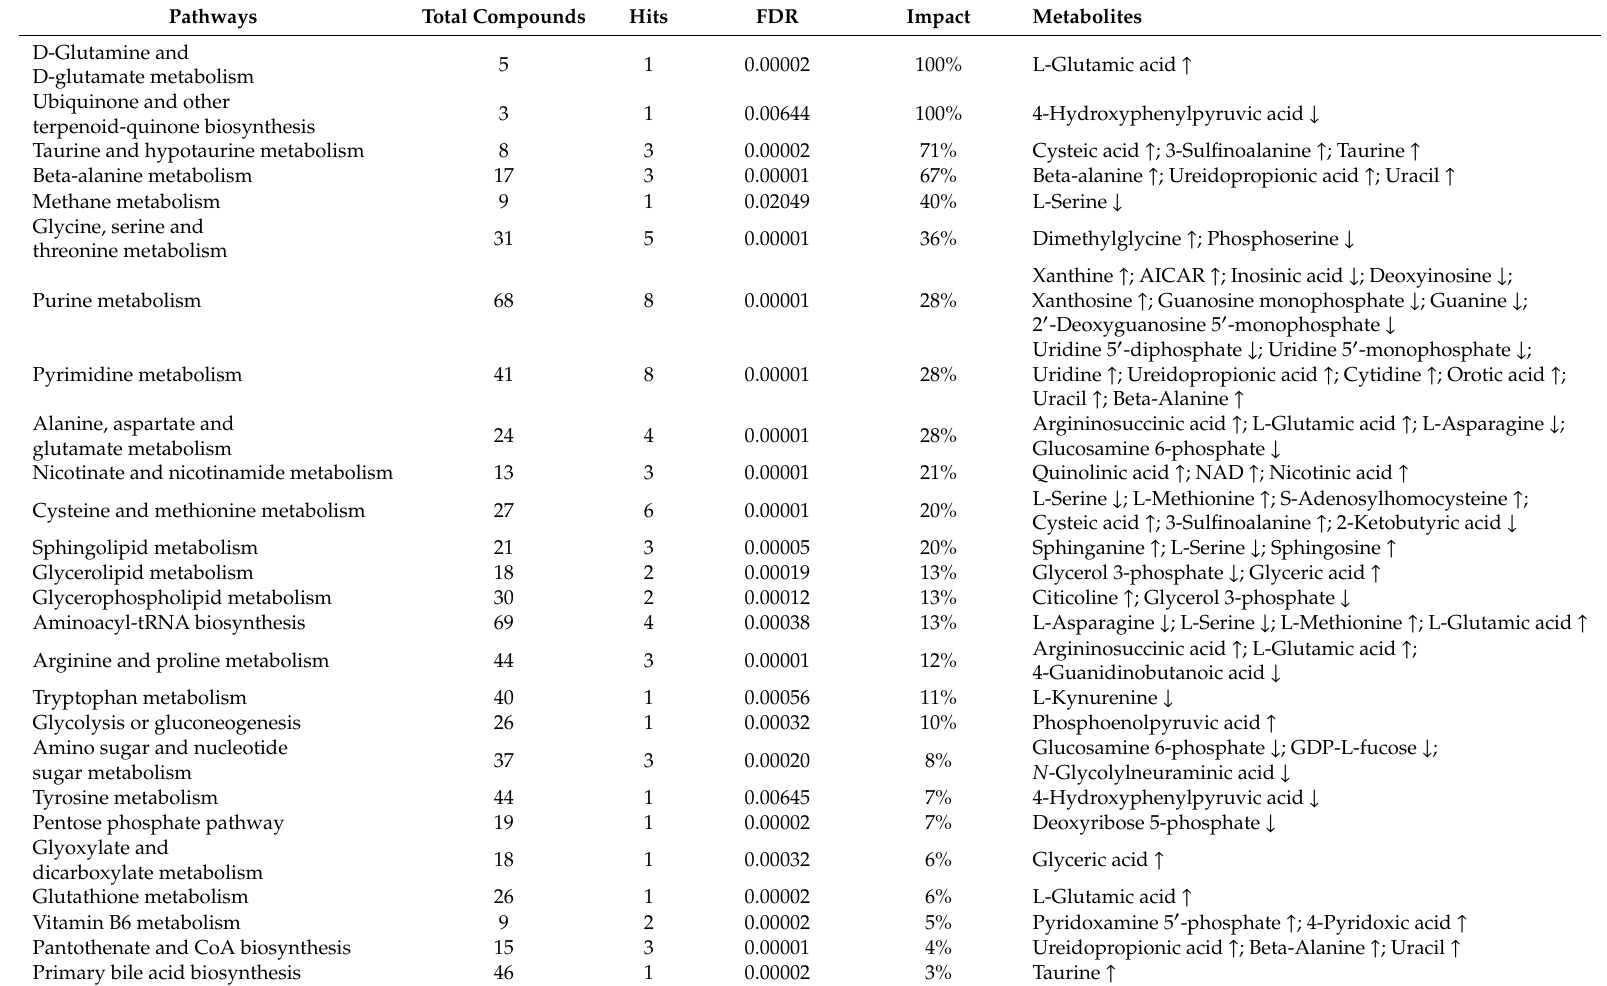
Table 2. Pathway (KEGG) enrichment analysis in the liver: comparison between males fed an HFD and males fed a CD. Pathways Total Compounds Hits FDR